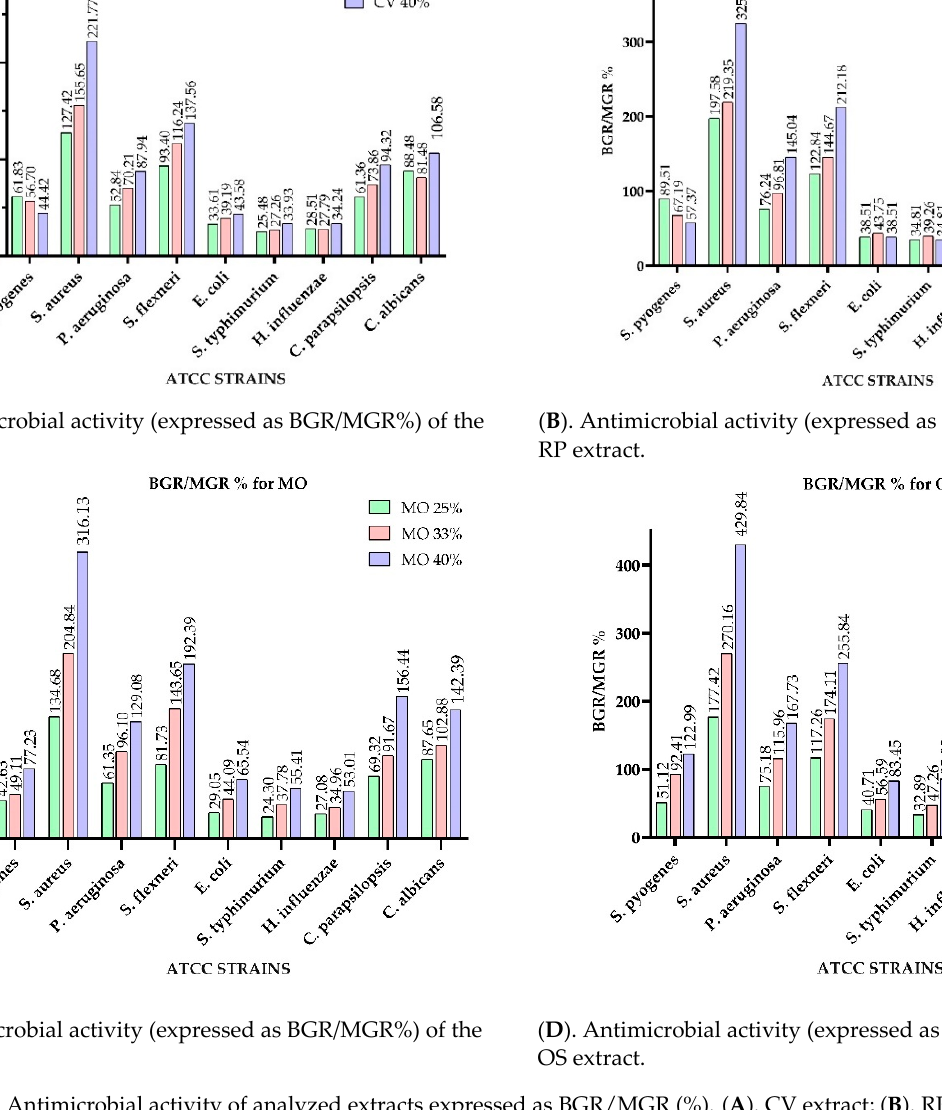
Figure 2. Antimicrobial activity of analyzed extracts expressed as BGR/MGR (%). ( A ). CV extract; ( B ). RP extract; ( C ). MO extract; ( D ). OS extract.